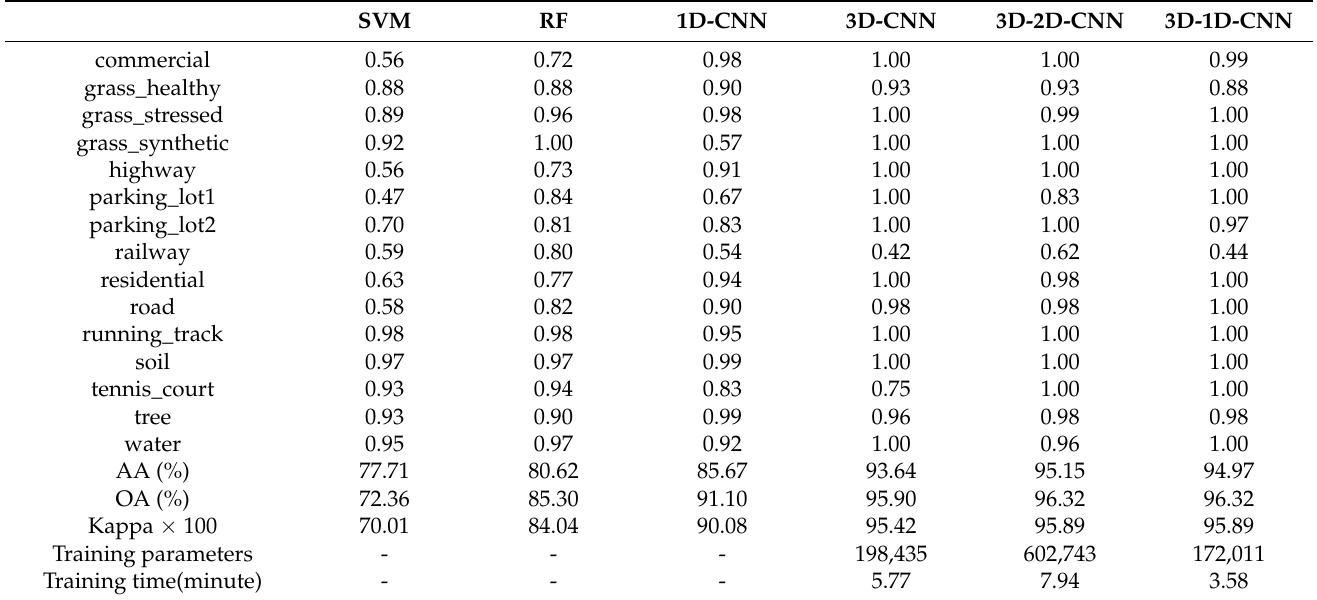
Table 6. Performance comparison of different classification methods on the Houston